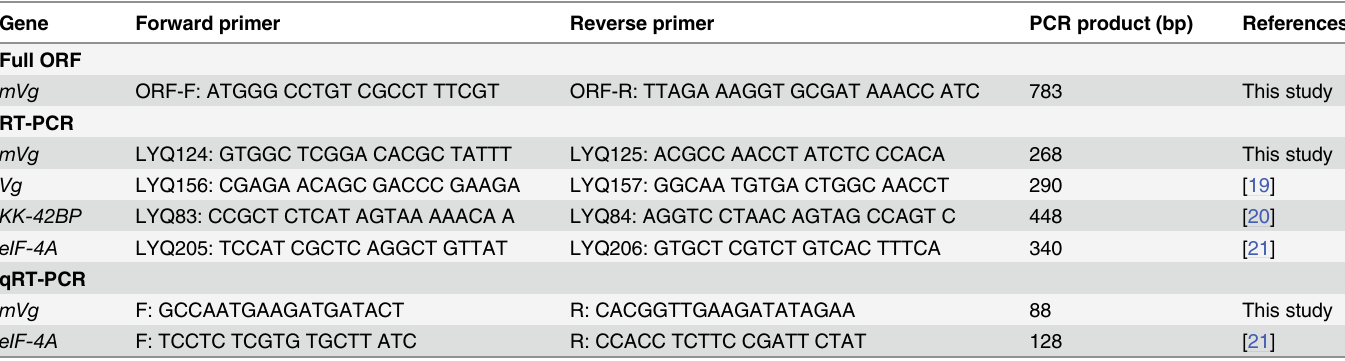
Table 1. Primers for RT-PCR used in this